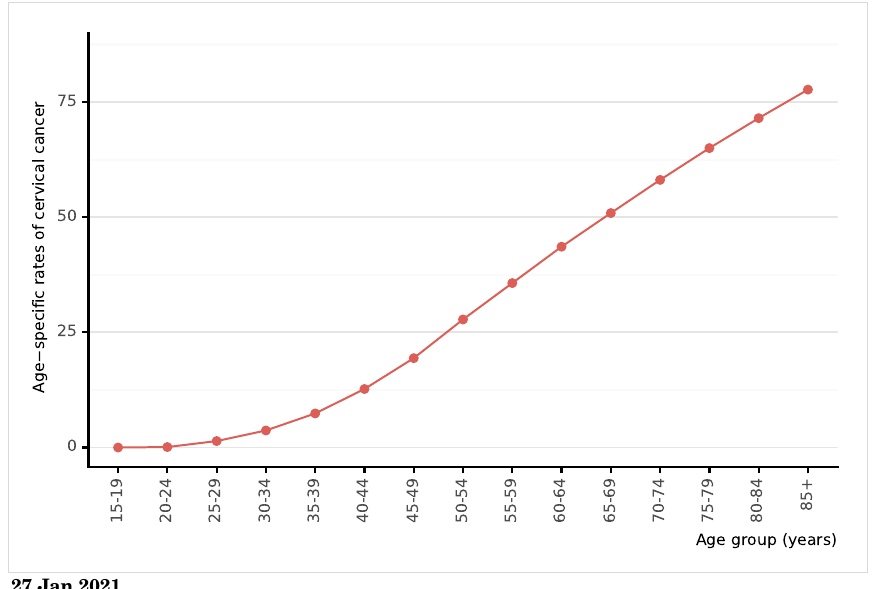
Figure 11: Age-specific mortality rates of cervical cancer in India (estimates for 2020)